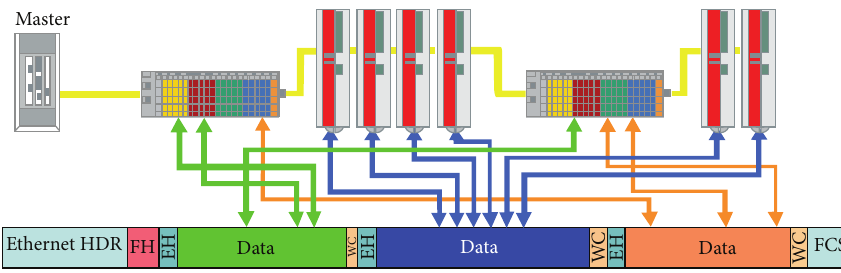
Figure 1: EtherCAT frame processing